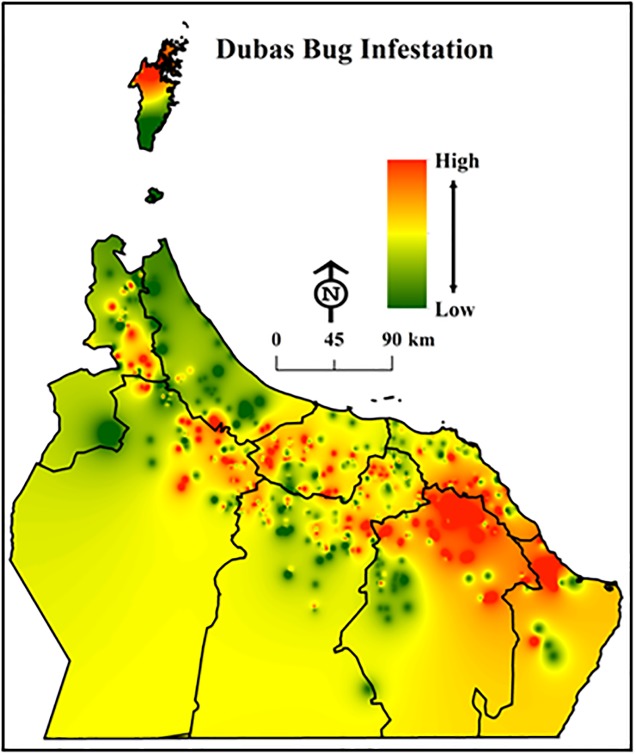
Raster map layer illustrating interpolated values of Dubas bug infestations in northern Oman (Esri ArcGIS 10.3).